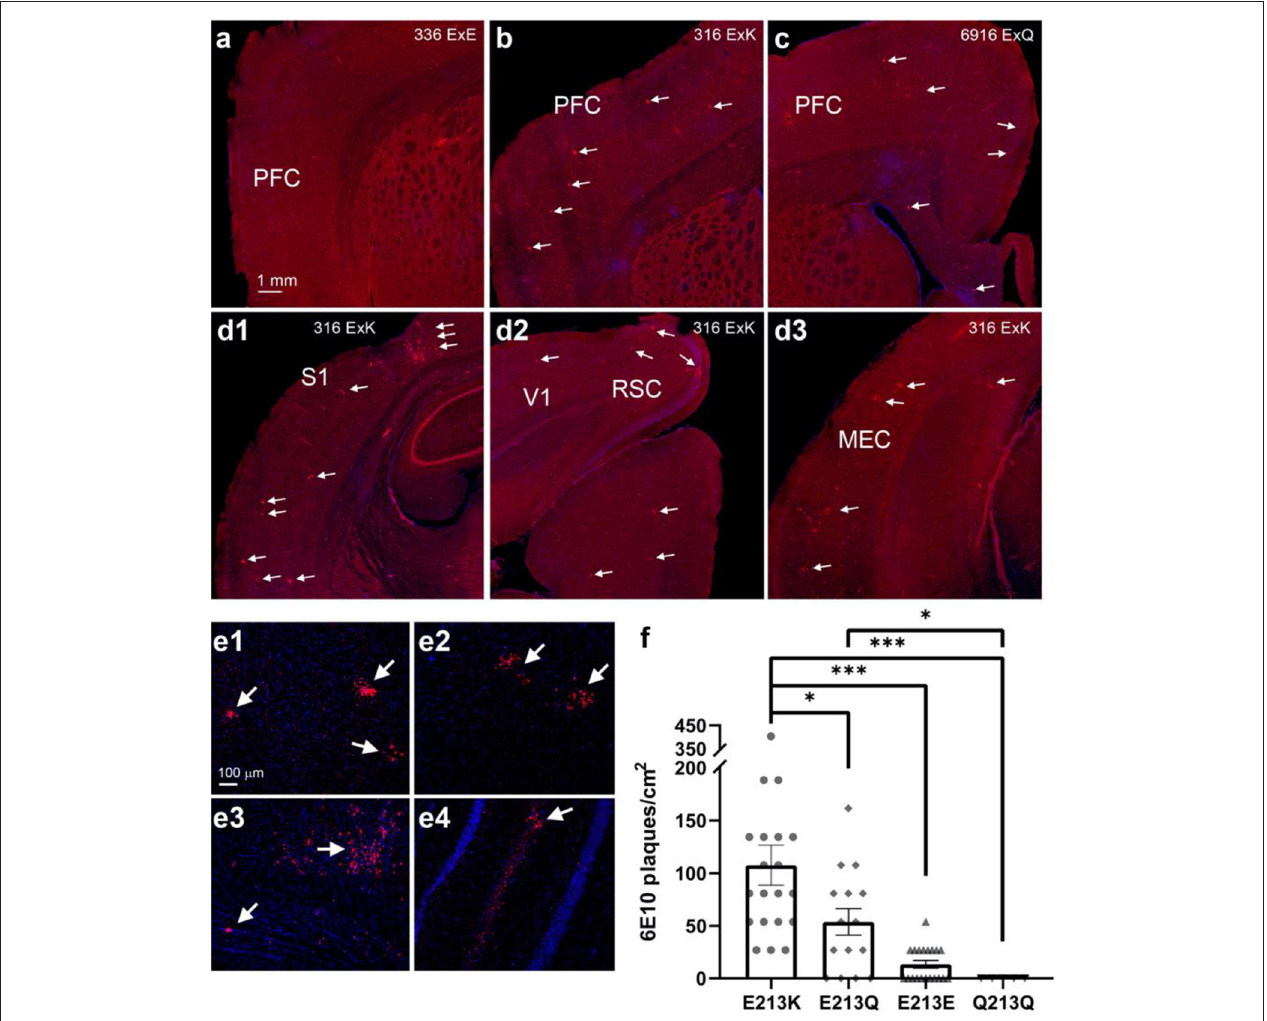
FIGURE 5 | Degu carrying the odAPOE allele E213K presented the highest β -amyloid plaque accumulation in the brain. (a-c) PFC comparison of right brain hemispheres of degu presenting three different residue variants: E213E (a) , E213K (b) , and E213Q (c) . Residue variants E213K and E213Q show brain plaque depositions throughout the PFC, while wild-type E213E shows no perceivable plaques. White arrows denote β -amyloid plaques. (d1-d3) Widespread β -amyloid plaque depositions seen through various posterior brain regions in an E213K variant carrier. White arrows denote β -amyloid plaques. (e1-e4) Confocal micrographs of cortical (e1-e3) and hippocampal plaques (e4) . (f) There were among-variant differences in the number of plaques, with the E213K variant carriers showing significant differences compared with carriers of the other variants (4 E213K cases; 8 other cases; Linear mixed-effect model (LME) tests. (* P < 0.05, *** P < 0.001). PFC, prefrontal cortex; S1, primary somatosensory cortex; V1, primary visual cortex; RSC, retrosplenial cortex; MEC, medial entorhinal cortex.